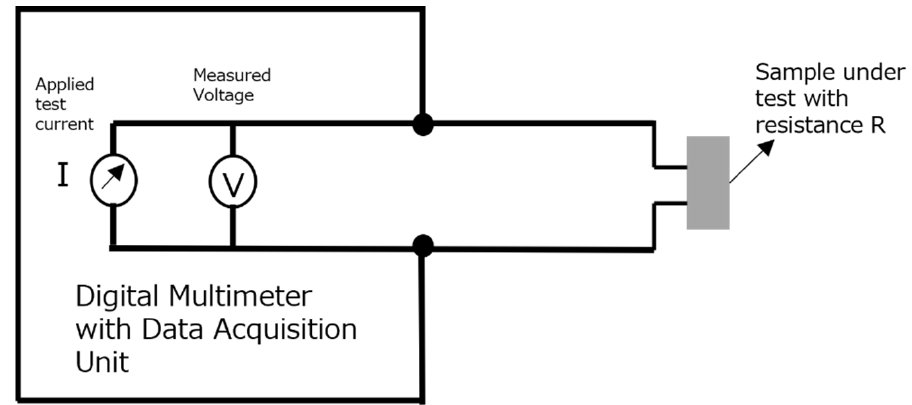
Figure 2. The 2W DC resistance measurement method.